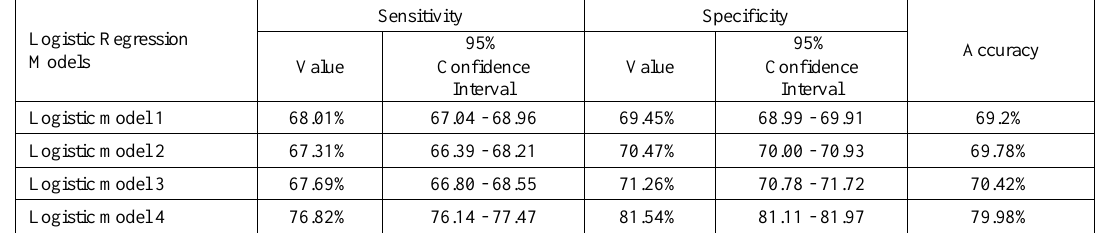
Table 1. Sensitivity, specificity and overall results of Logistic regression models